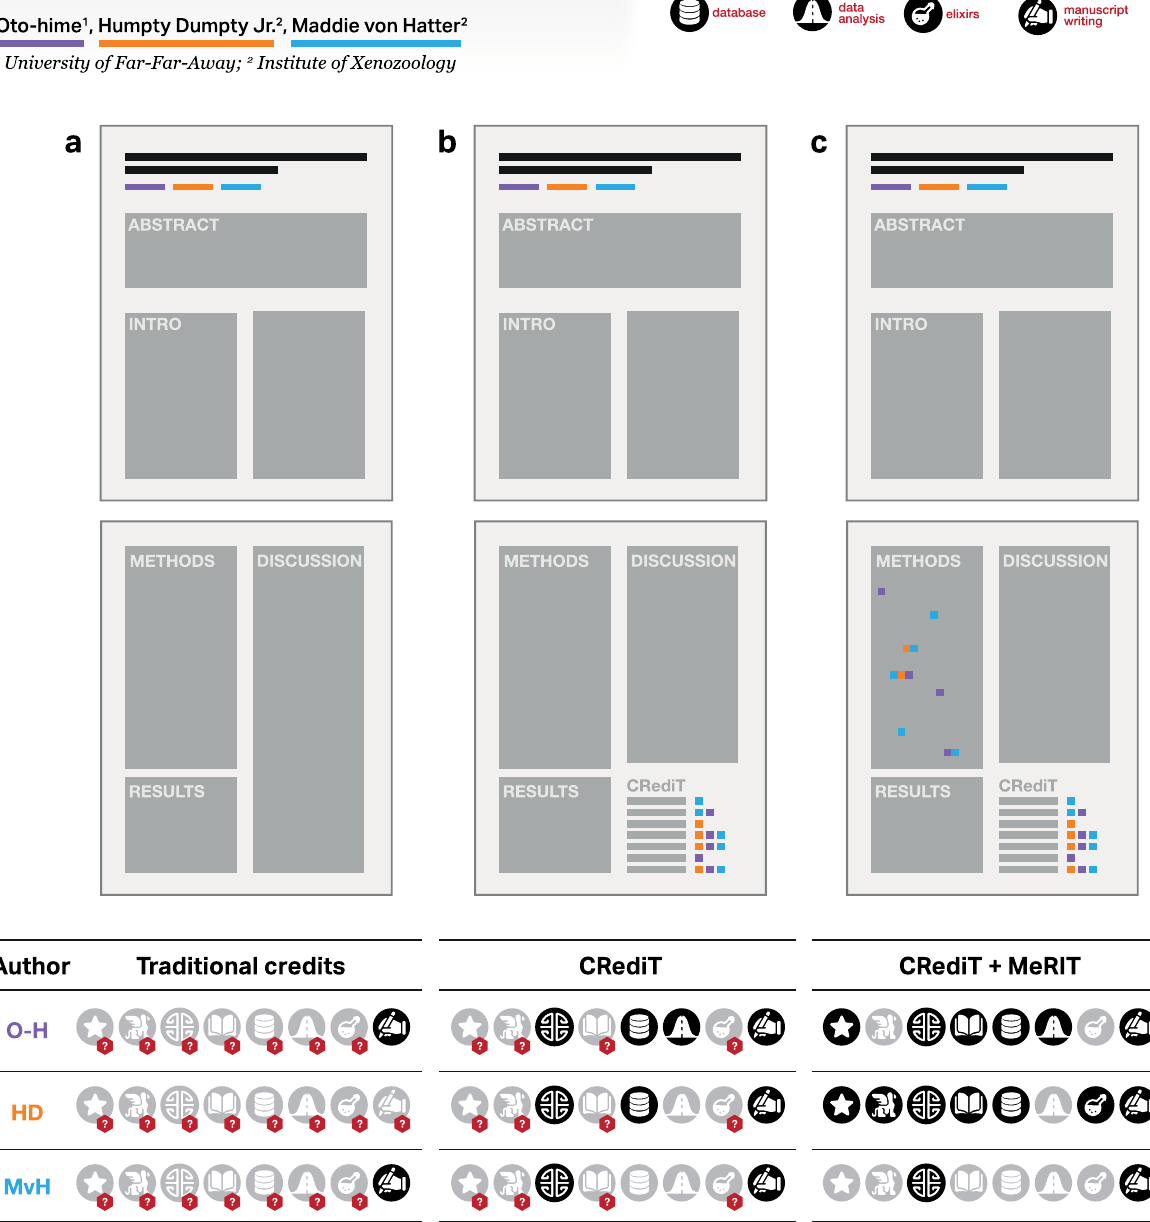
last author would have written the text, but it cannot be certain, b CRediT can clarify some of the tasks authors did, but not all tasks, especially methodological ones, and c the use of CRediT and MeRIT together can clarify all author